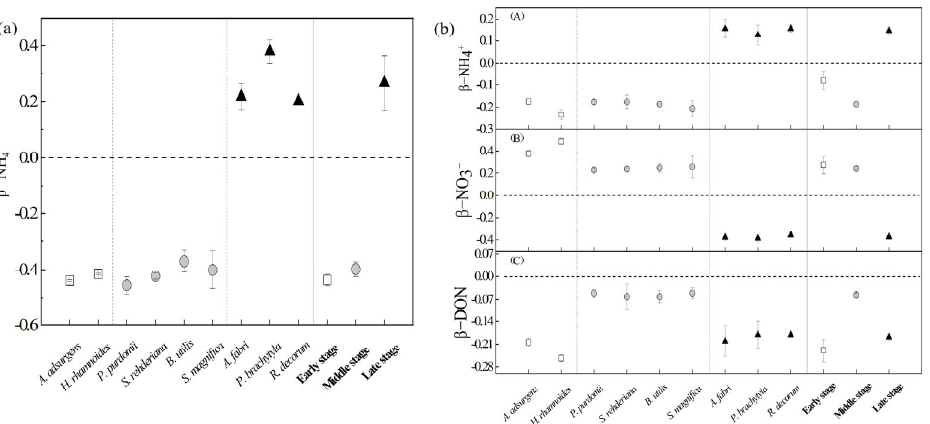
Figure 5. Preference ( β ) for one soil N source of dominant plants based on the two-source mixing model ( a ) and the three-source mixing model ( b ) at different successional stages. Positive β values denote a preference. Negative β values or β = 0 indicate no preference. White, gray, and black circles represent species from the early − (~12 year), middle − (~40 year), and late − (~120 year) succession stages, respectively. A, B and C mean preference for NH 4+ , NO 3- and DON, respectively.